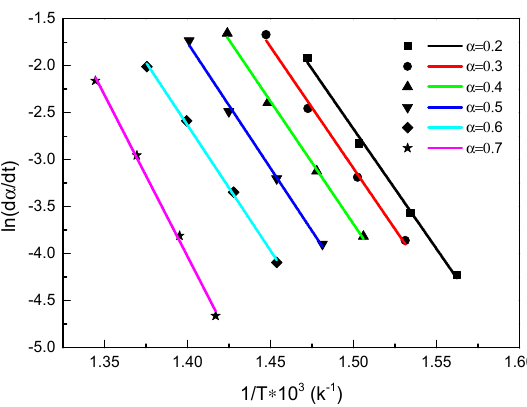
α   d -1/T by the Friedman method under inert atmosphere.   dt  